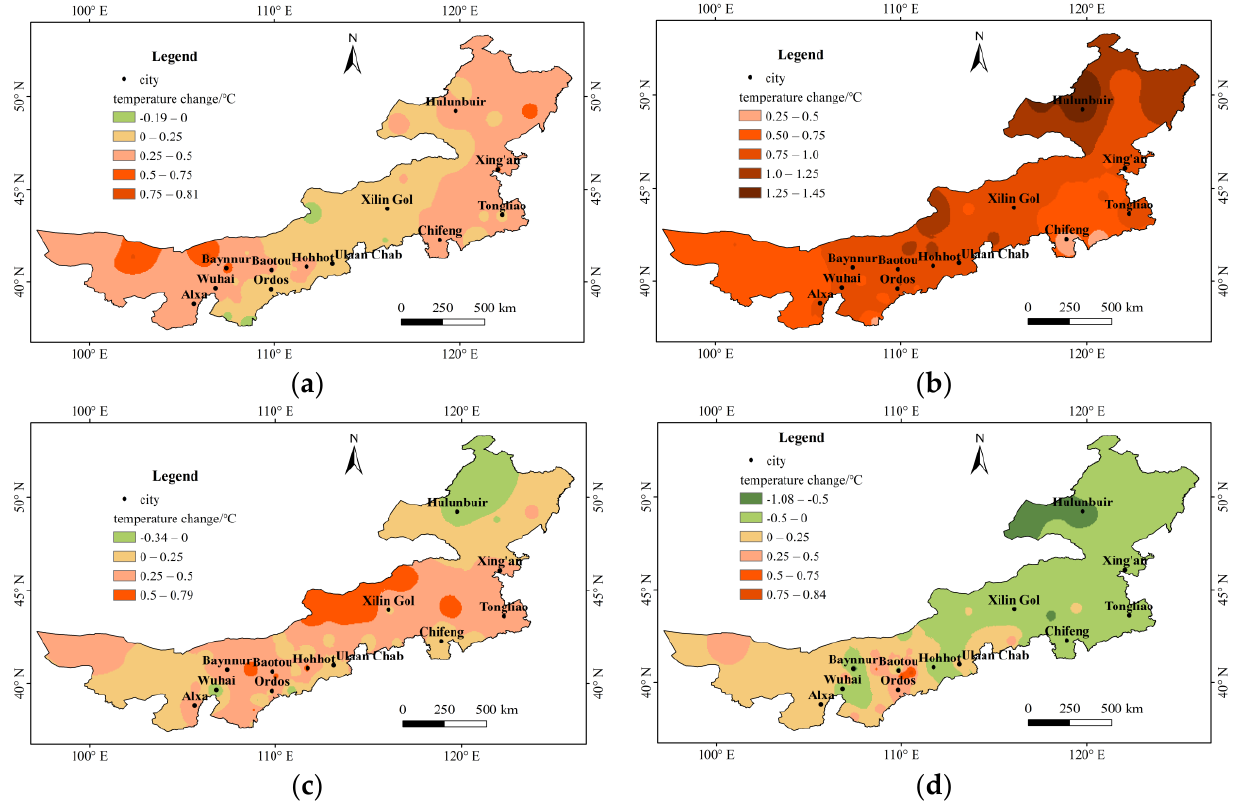
Figure 6. Temperature changes in Inner Mongolia during different periods. ( a ) Description of temperature changes in Inner Mongolia in the 1980s and 1970s; ( b ) Description of temperature changes in Inner Mongolia in the 1990s and 1980s; ( c ) Description of temperature changes in Inner Mongolia in the 2000s and 1990s; ( d ) Description of temperature changes in Inner Mongolia from 2011–2017 and in the 2000s.